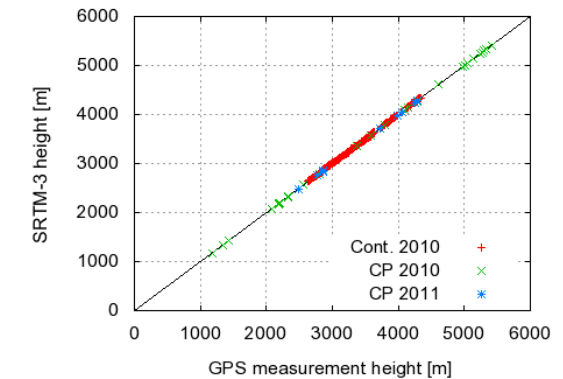
Figure 6. Histogram of height differences between SRTM-3 and ground-based GPS measurements.